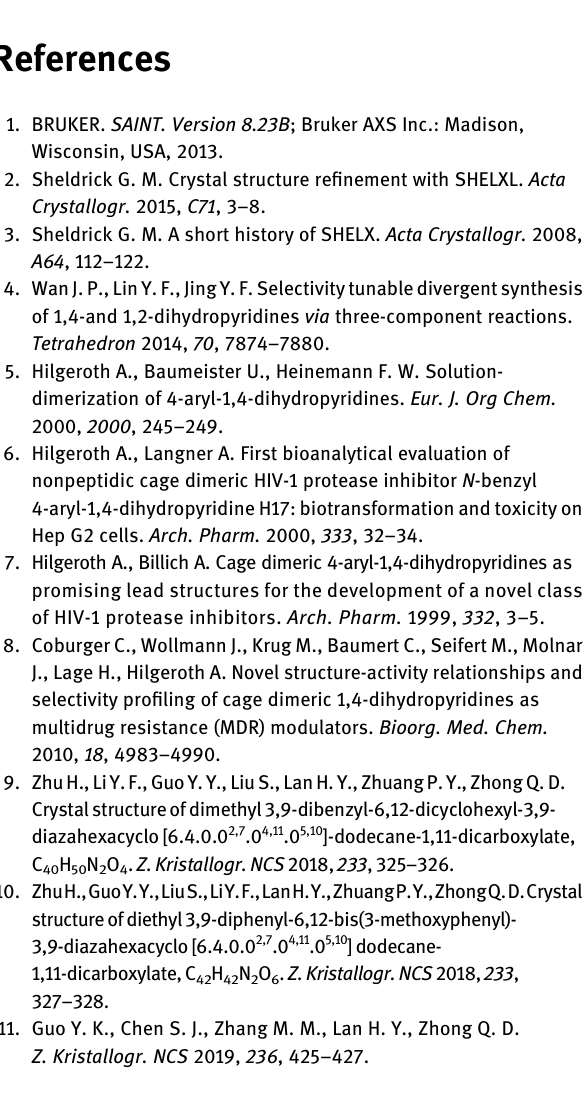
adjusted to 365 nm, a complete [2 + 2] reaction occurs, and the title compound is completely cyclized (see picture). It is worth to note that compared to previous studies, it can be shown that the electronic effect has little or no effect on the cyclization, and the incident wavelength plays a decisive role in the cycloaddition reaction. In the crystal structure,